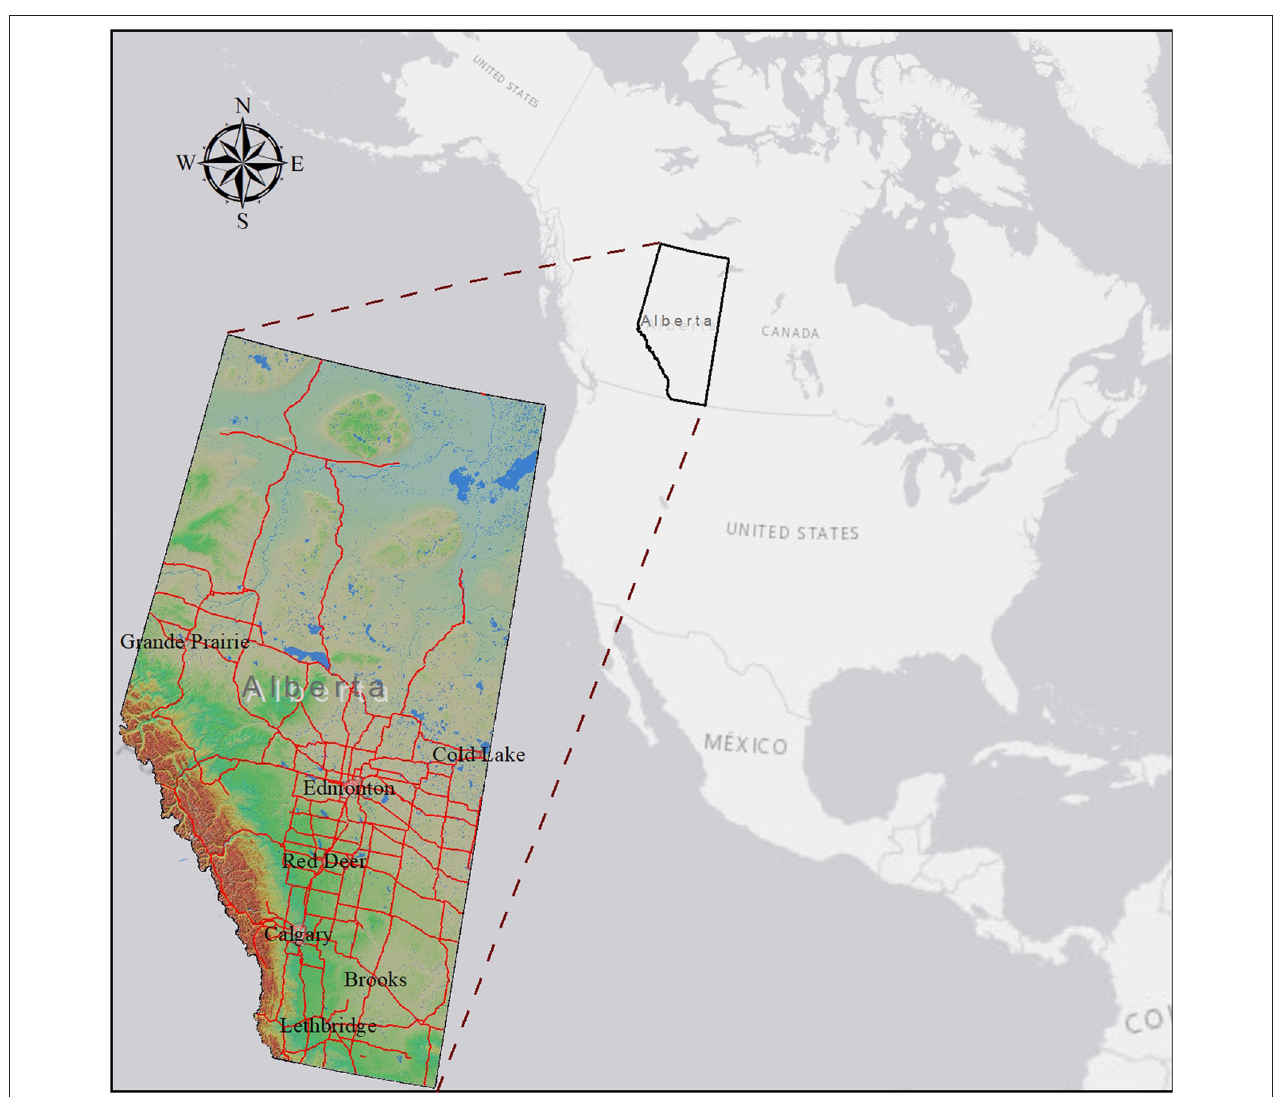
FIGURE 1 | A map showing the geographic location of the western Canadian province of Alberta. Labels are the major cities and red lines are major highways of